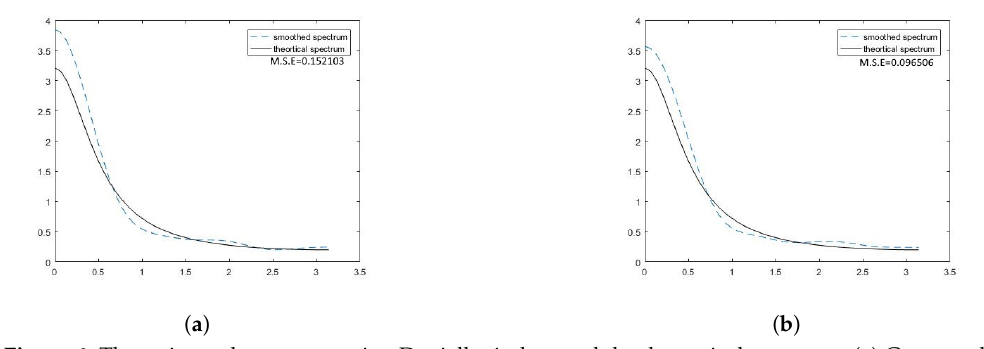
Figure 6. The estimated spectrum using Daniell window and the theoretical spectrum. ( a ) Generated observations. ( b ) Forecasted observations.